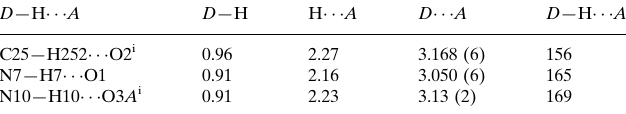
Hydrogen-bond geometry (A˚ , (cid:2)